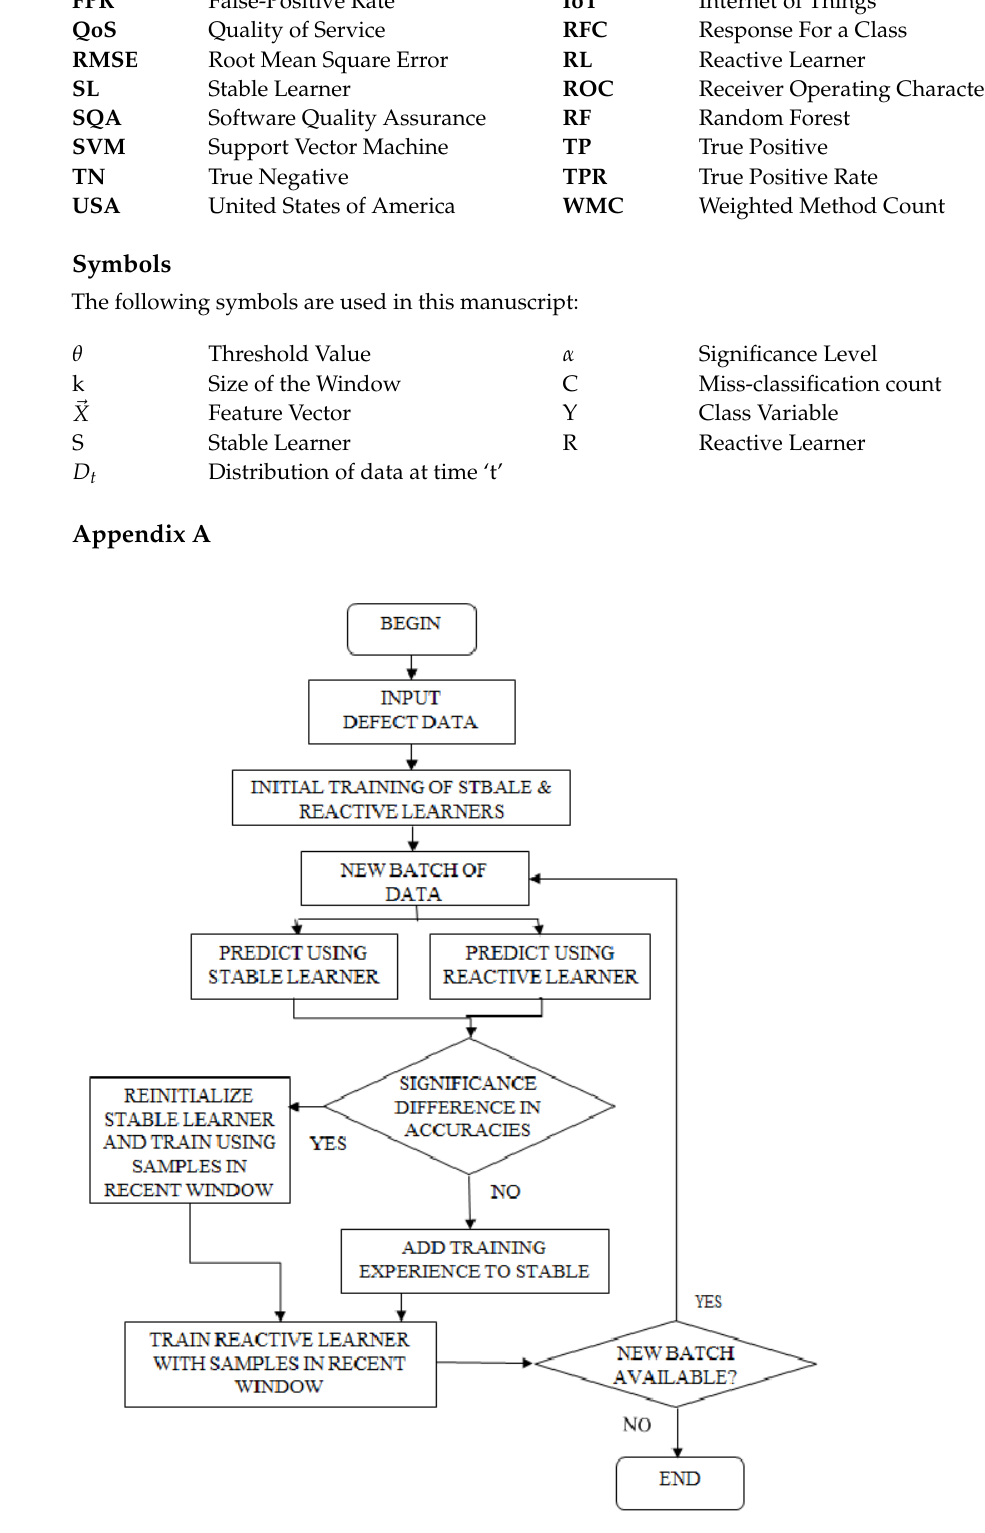
Figure A1. PL-based Approach in SDP for detecting